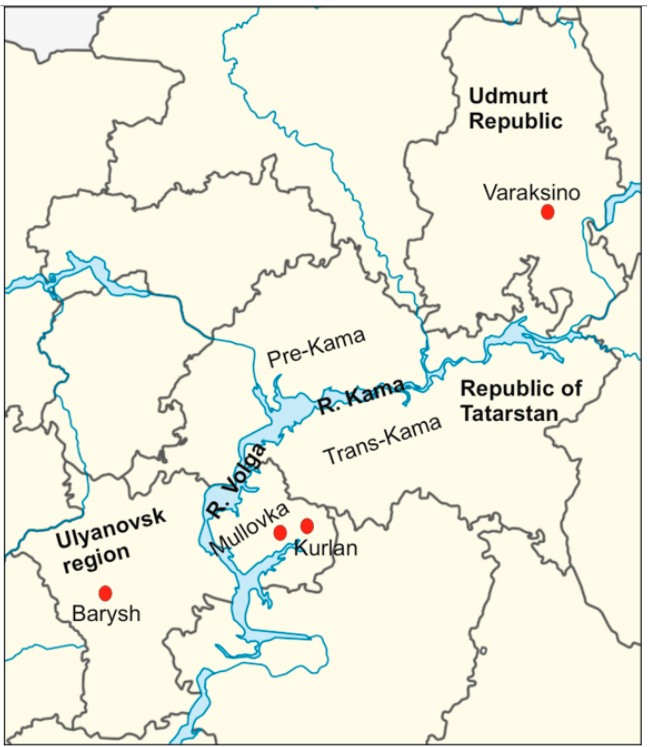
Figure 1. Geographical location of rodent trapping sites in the ULR and UR of the VFD. The red dots represent the trapping sites. The map was modified from free blank SVG vector map of Russia (MAPSVG, from https://mapsvg.com/maps/russia, accessed on 12 January 2022). In total, 43 bank vole lung tissues from VFD were found to be positive for PUUV RNA after the initial screening. The complete coding sequences (CDS) (1302 bp) for the S, partial M (1014 bp), and L (603 or 665 bp) segment sequences were only obtained from 11 samples and used for analysis. All PUUV strains obtained were named to include their corresponding virus acronym name, trapping region, host acronym name/number, and trapping year (for example, for PUUV/Varaksino/MG_1937/2019, we will use MG1937 in short).